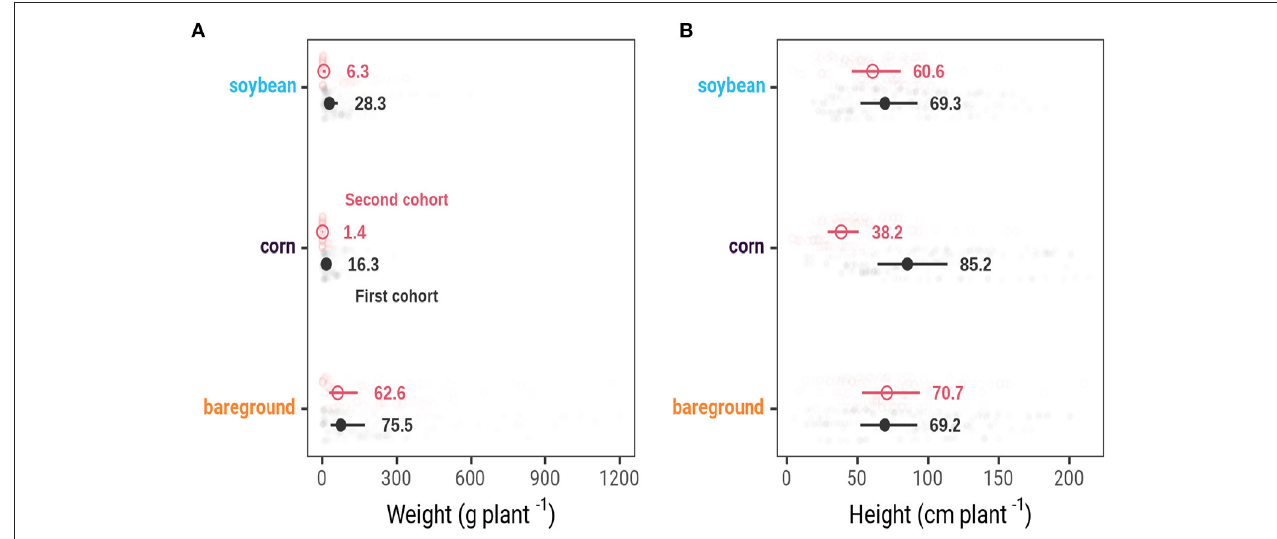
FIGURE 4 | Palmer amaranth biomass (A) and height (B) growing in corn, bareground, and soybean nested across Arlington, WI, Clay Center, NE, Grant, NE, Lincoln, NE, and Macomb, IL.